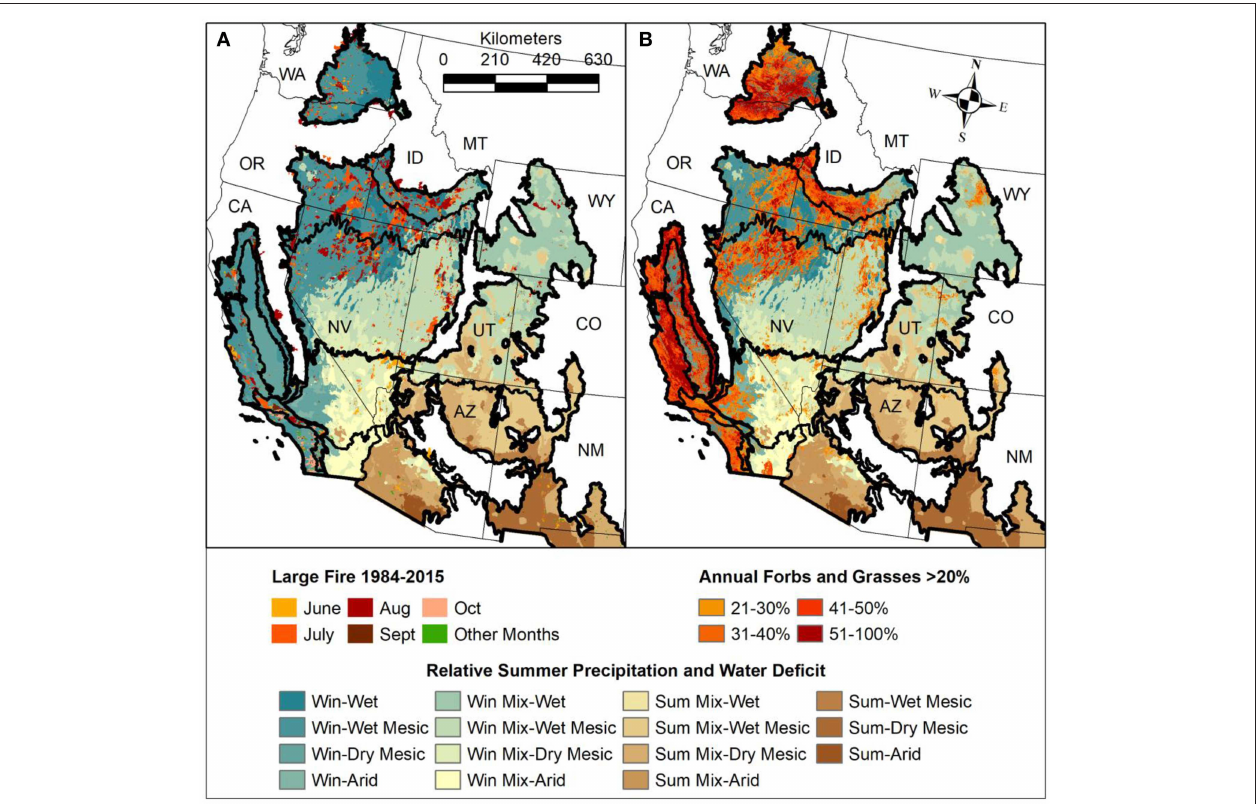
FIGURE 5 | A generalized aridity index (Dobrowski et al., 2013) combined with the timing of precipitation (winter or summer) based on 30-year normal annual values (PRISM Climate Group, 2016) and overlaid with (A) large fires in the months of June, July, August, September, October, and other months (1984–2015; Monitoring Trends in Burn Severity [MTBS], 2018 ) and (B) percentage cover of annual forbs and grasses derived from the per-pixel maximum values from 2015–2017 (Jones et al.,